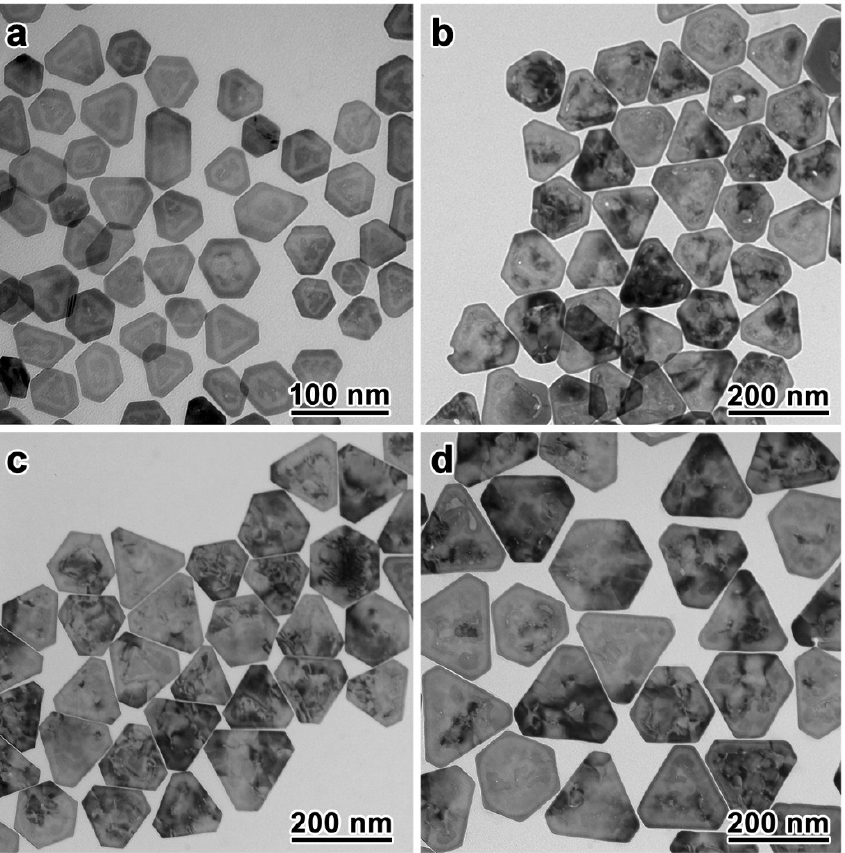
Figure 3. Synthesis of Au nanoplates with different sizes. ( a – d ) TEM images of the Au nanoplates with average edge lengths of 48, 115, 132, and 167 nm, respectively.